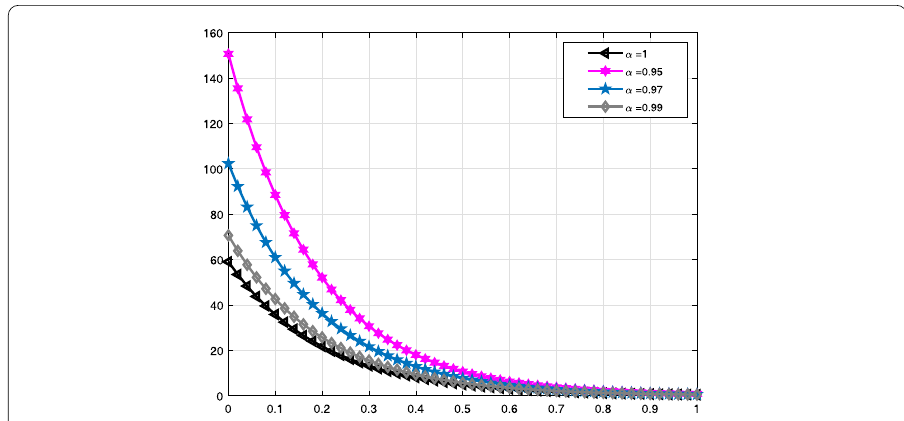
Figure 9 Comparative analysis with proportional derivative for V e ( t )